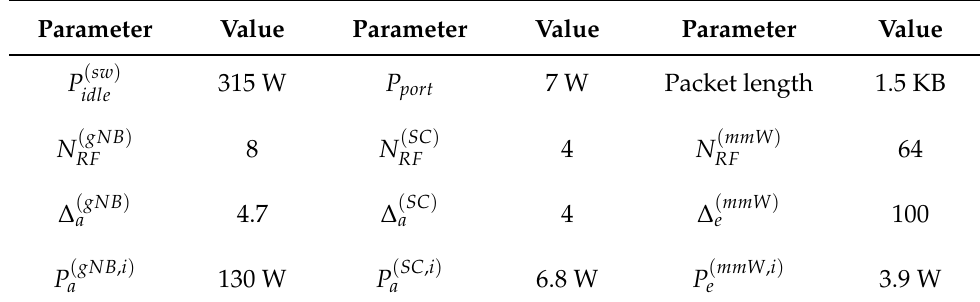
Table 4. Simulation Parameters